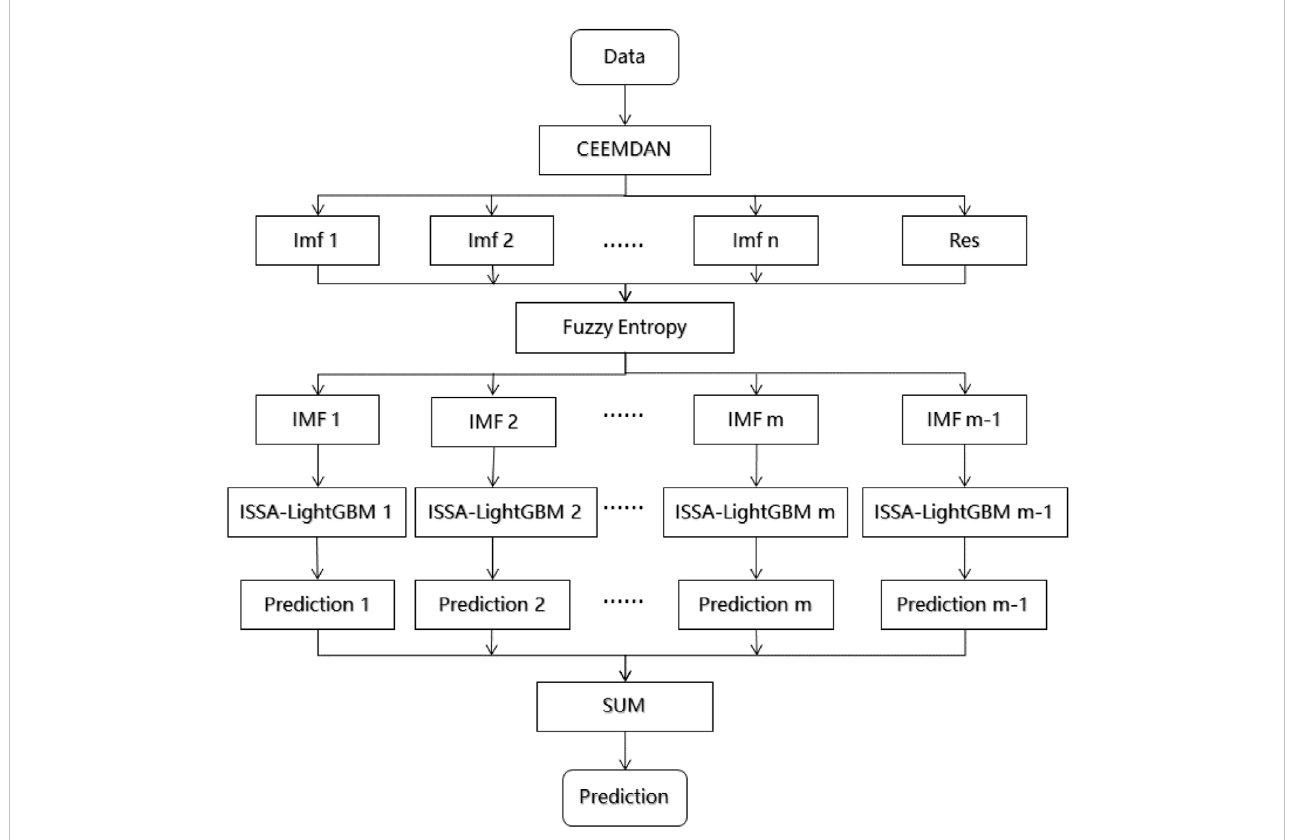
FIGURE 4 CEEMDAN-FE-ISSA-LightGBM model structure.